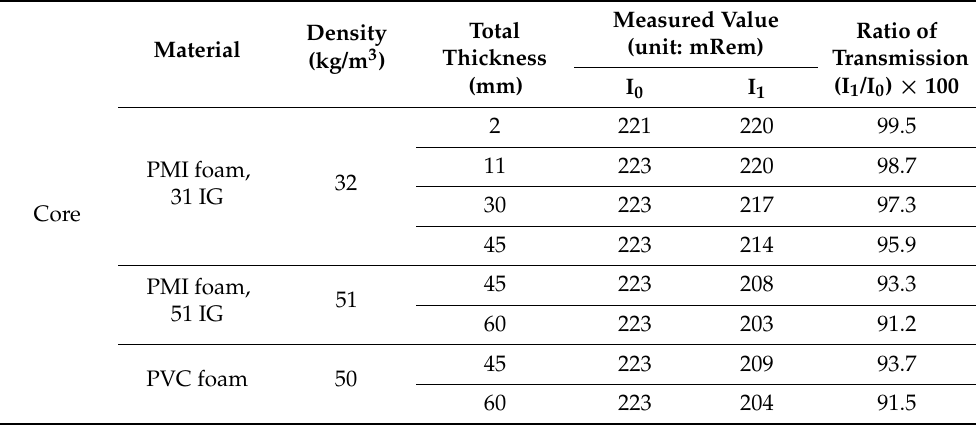
Table 4. X-ray Transmission ratio of foam material.